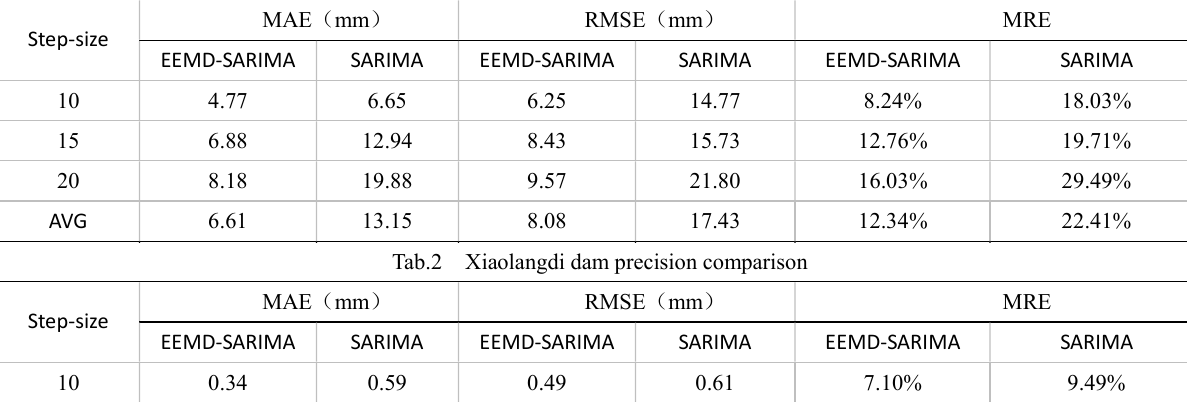
Tab.2 Xiaolangdi dam precision